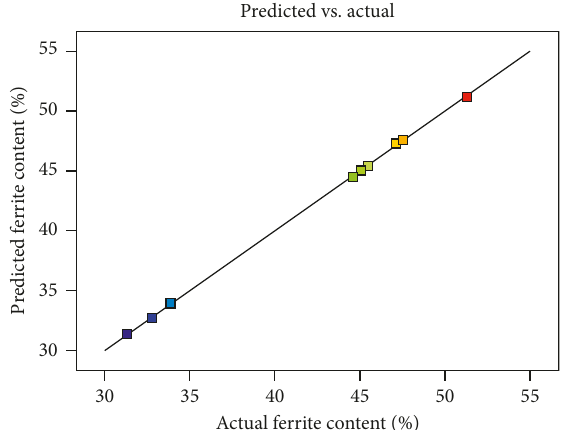
Figure 2: Predicted and experimental results of ferrite content.